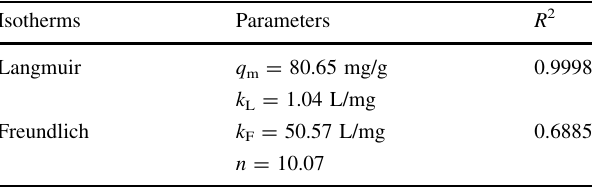
Table 1 Isotherm parameters for AM adsorption on AC-PEI at 298 K